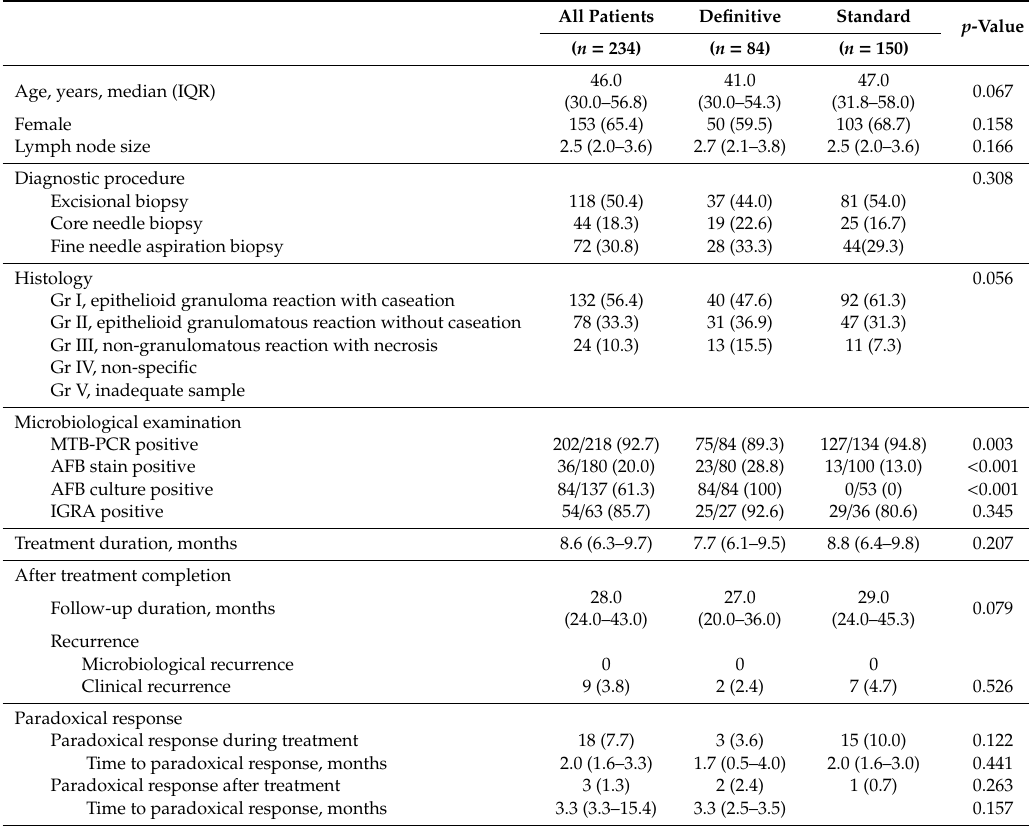
Table 2. Comparison of clinical feature and clinical outcomes between the definitive ( n = 84) and standard ( n = 150) anti-TB therapy